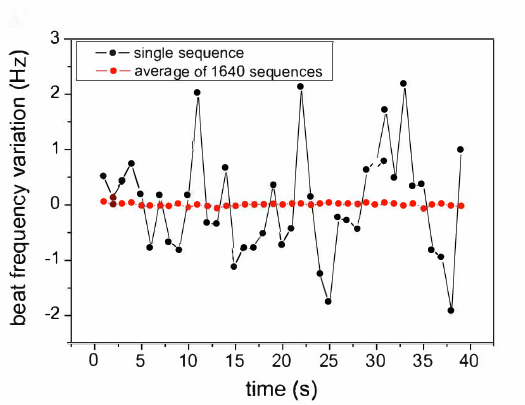
Figure 9. The experimental frequency shift reported in Figure 9a of [47] (courtesy of Optics Com- munications). The black dots give the instantaneous signal, the red dots give the average of the signal over 1640 sequences. For a laser frequency ν 0 = 2.82 · 10 14 Hz, ∆ ν = ± 1 Hz corresponds to a fractional value ∆ ν / ν 0 of about ± 3.5 · 10 − 15